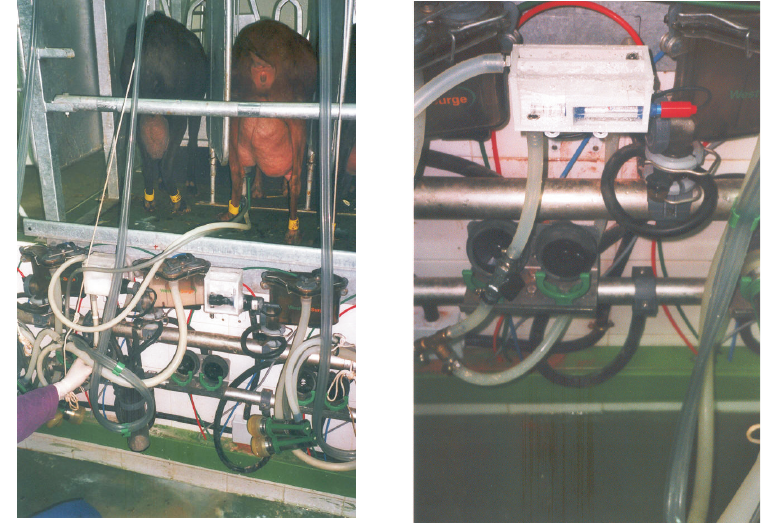
Figure 6. Detail of the probes in the milking parlour.